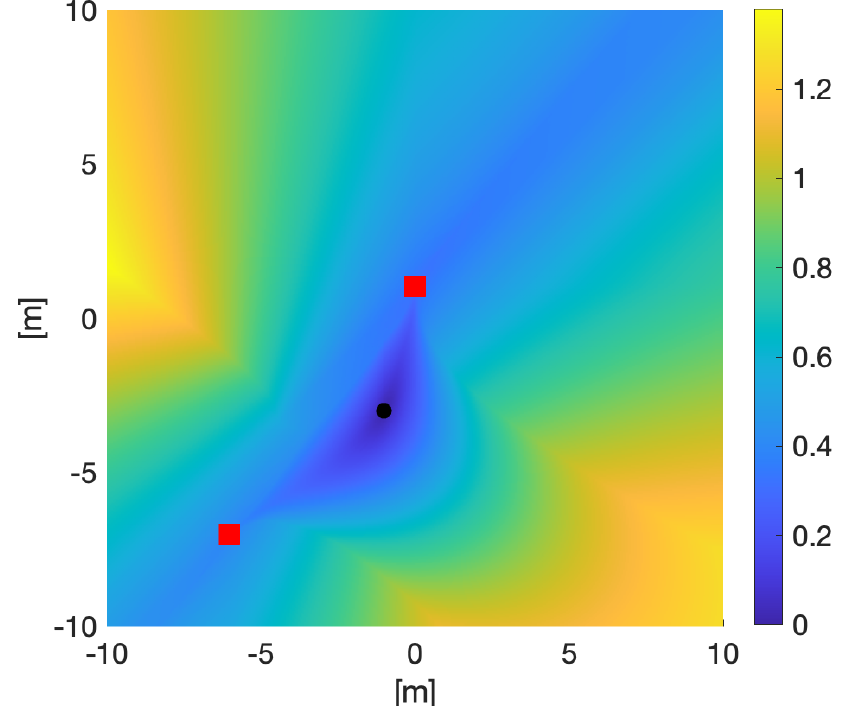
Figure 4. Geodesic distance on Ω = [ − 10,10 ] × [ − 10,10 ] from the point ( − 1, − 3 ) with sensors at ( − 7, − 6 ) and ( 0,1 ) (raised at a height 1 above Ω ). The distance was calculated using a Fast Marching formulation of the geodesic equation. The fact that the geodesics follow the gradient of this distance allows comparison with Figure 3.